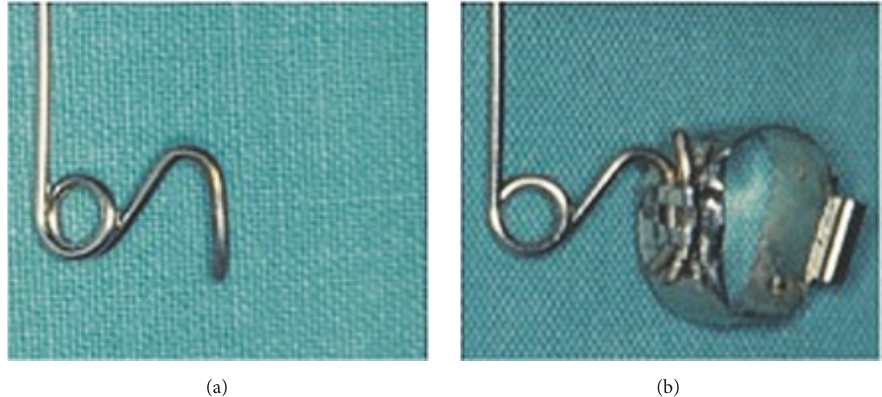
Figure 5: Details of the single terminal (a) and the terminal introduced together with the wire segment of the same diameter into the Goshgarian tube and welded to the band (b).